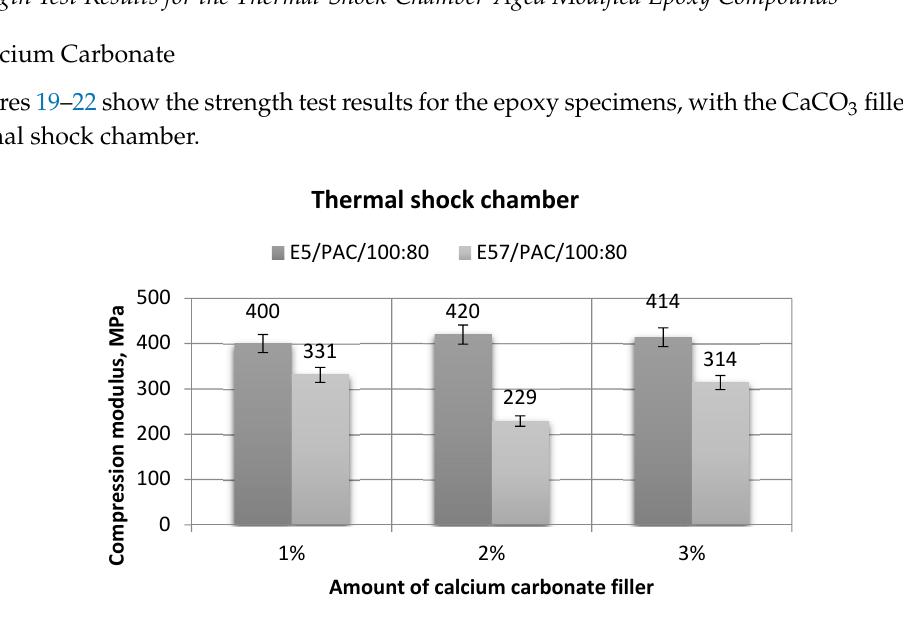
Figure 19. Comparison of the compression modulus between the E5 / PAC / 100:80 and E57 / PAC / 100:80 epoxy specimens modified by the calcium carbonate filler post-thermal shock chamber aging.